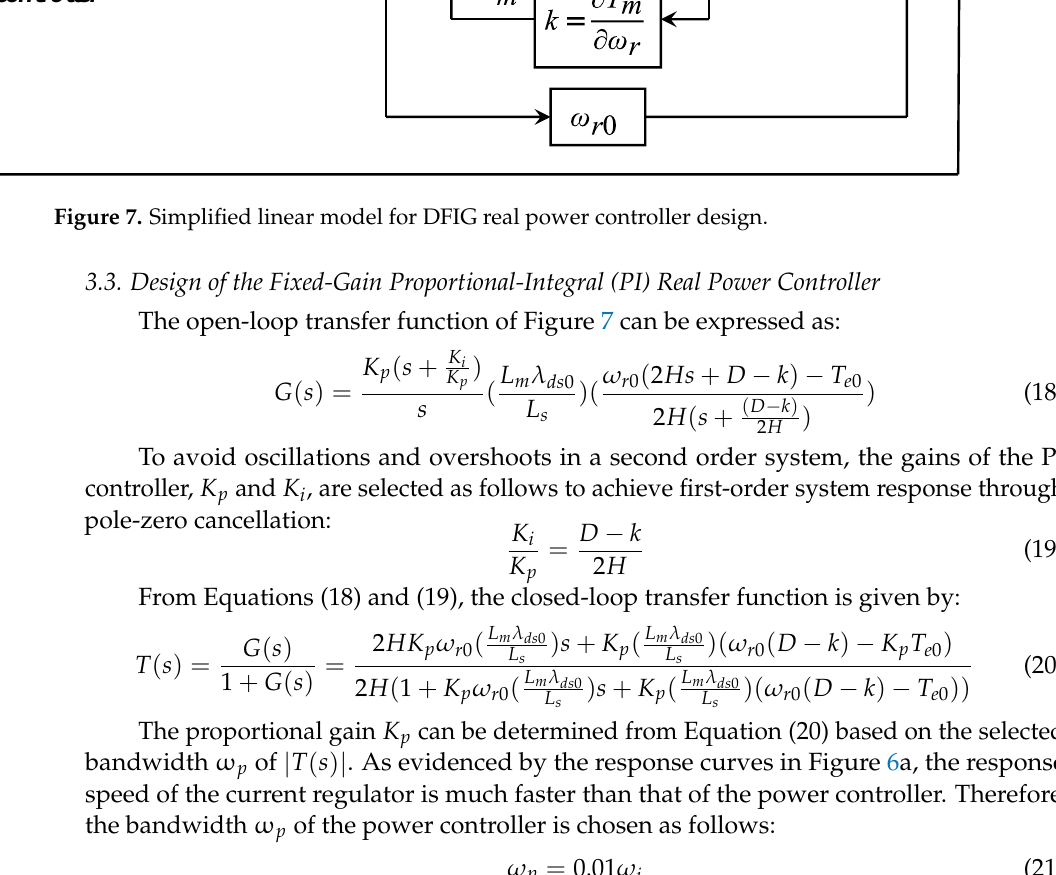
Figure 6. Dynamic response curves of the power controller and current regulator. ( a ) Dynamic response curves to step inputs to the current regulator loop and power controller loop. ( b ) Dynamic response of the power controller with and without current controller.